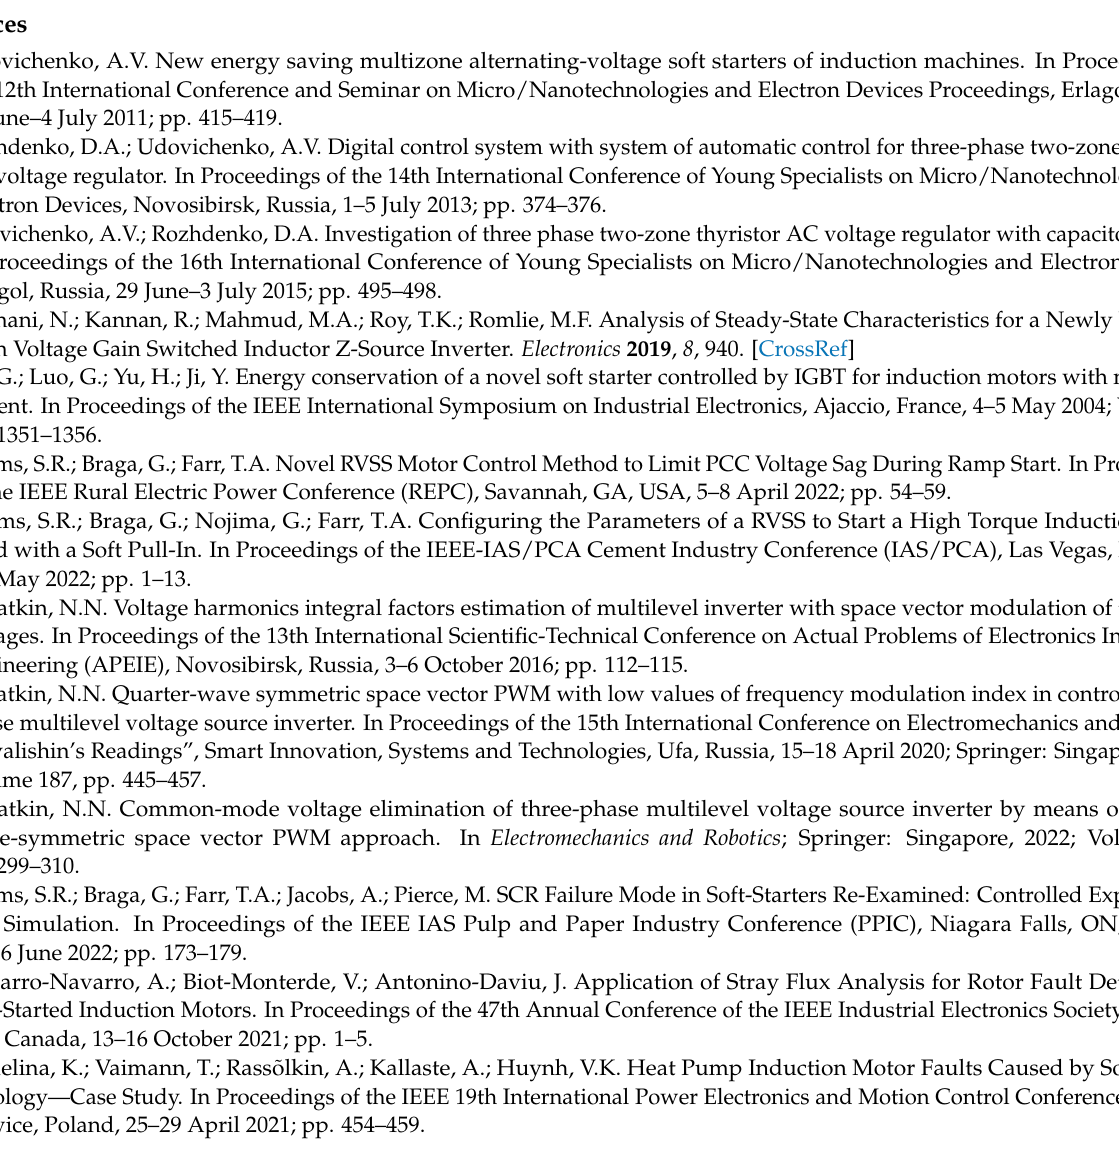
Figure A2. Motor current waveform for case of using relay controller with last zone disabled.